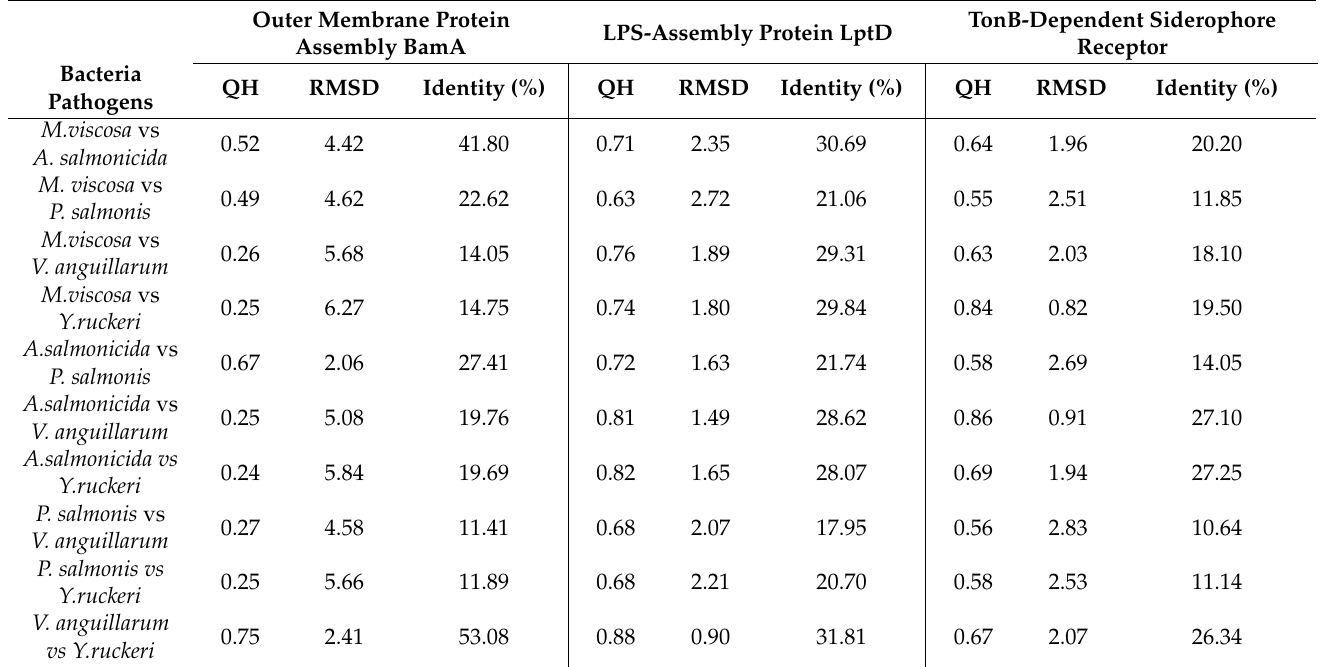
Table 3. Sequence and structural alignment of the common outer membrane antigens. QH, structural homology; RMSD, root mean square deviation.